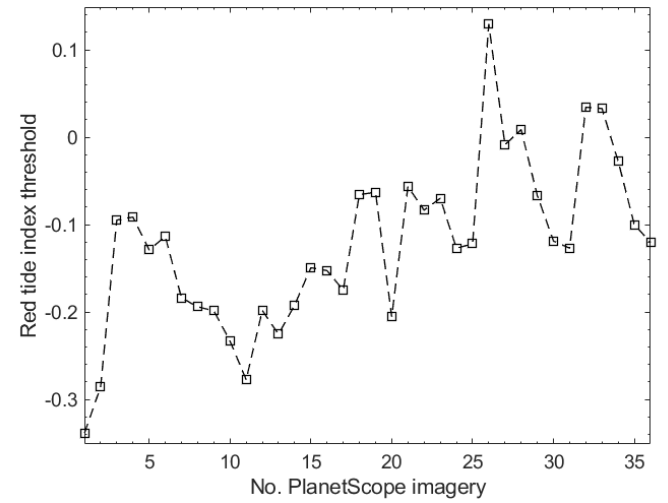
Figure 7. RTI thresholds of 36 PlanetScope images. The threshold was determined by the median RTI value of the red tide pixel group in each image.